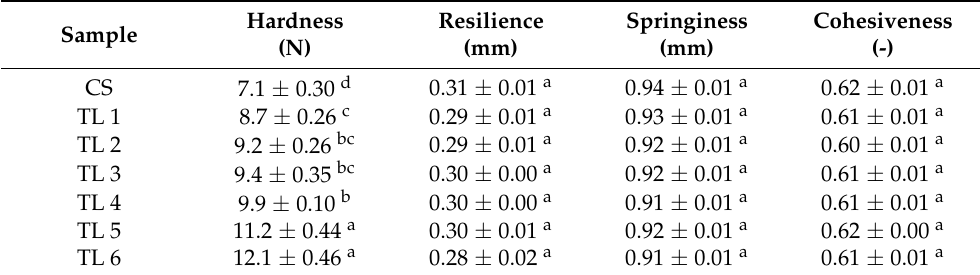
Table 3. Textural characteristics of bread enriched with Taraxacum officinale .